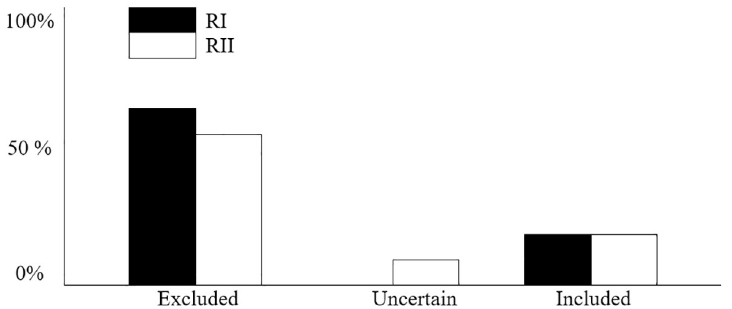
Fig 1. Agreement between the authors during the screening carried out via Rayyan. RI: Researcher I. RII: Researcher II.